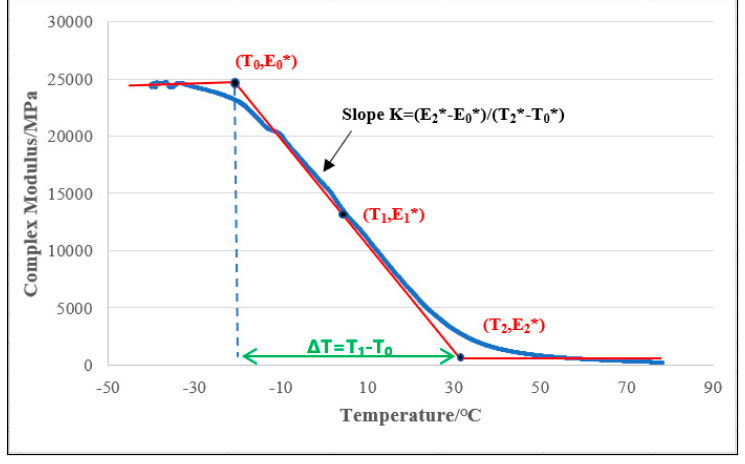
Figure 7. Complex modulus curve.